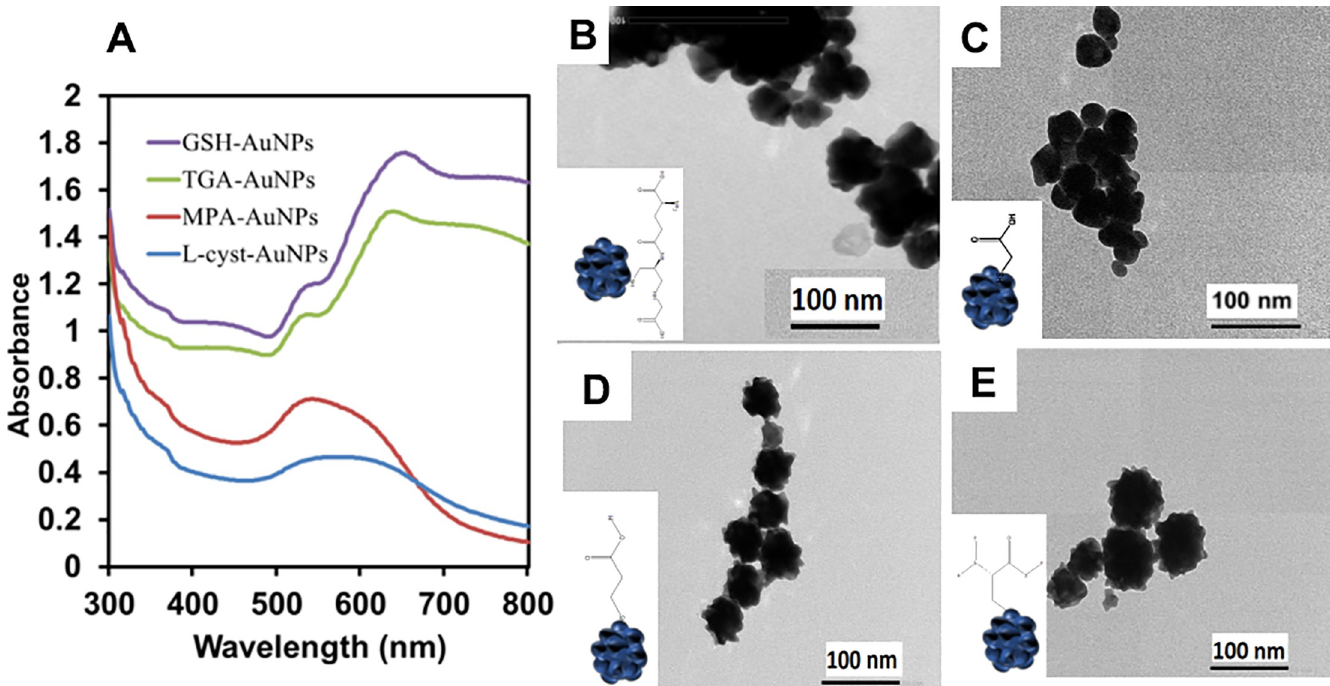
Fig 2. UV/vis absorption spectra (A) and TEM images (B–E) of the thiol-capped AuNPs. (B), (C), (D), and (E) denote GSH-, TGA-, MPA-, and L -cyst-conjugated AuNPs, respectively.